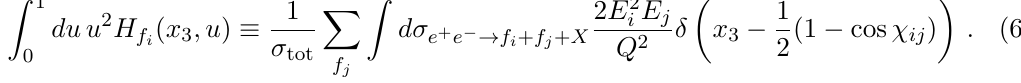
Figure 8. The squeezed limit of the EEEC. We let z